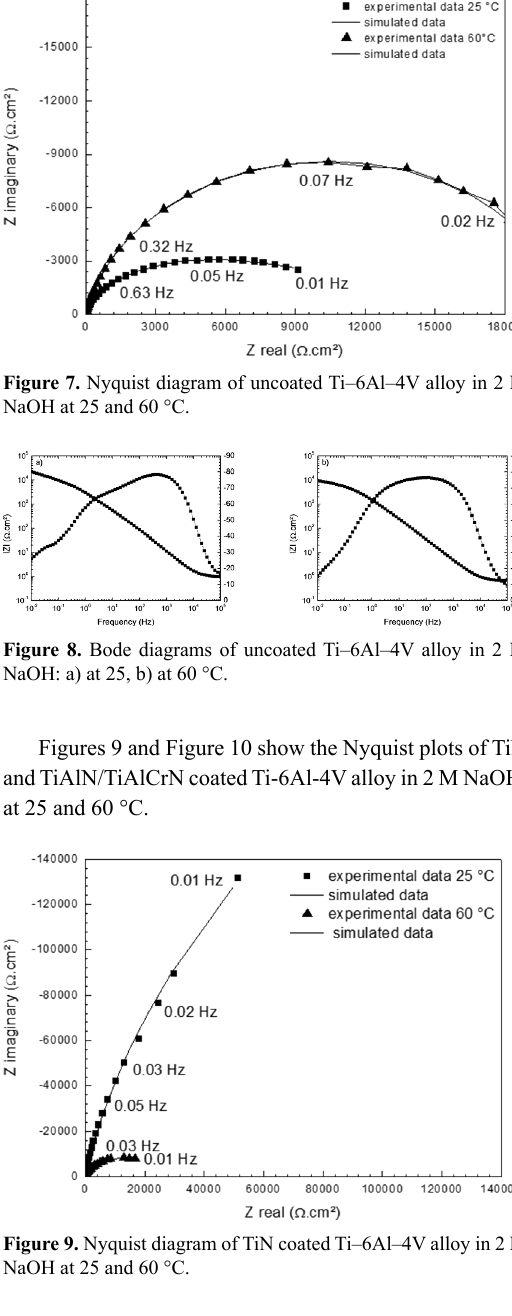
Figures 11 and Figure 12 show Bode diagrams of TiN and TiAlN/TiAlCrN coated Ti-6Al-4V alloy in 2 M NaOH, at 25 and 60 °C.